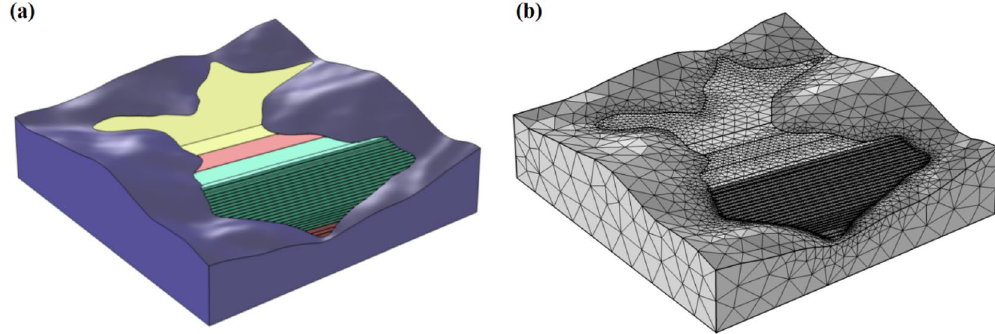
Figure 1. The model of tailings reservoir. ( a ) The 3D computation model of tailings reservoir and surrounding surface; ( b ) The geometric model and the grid